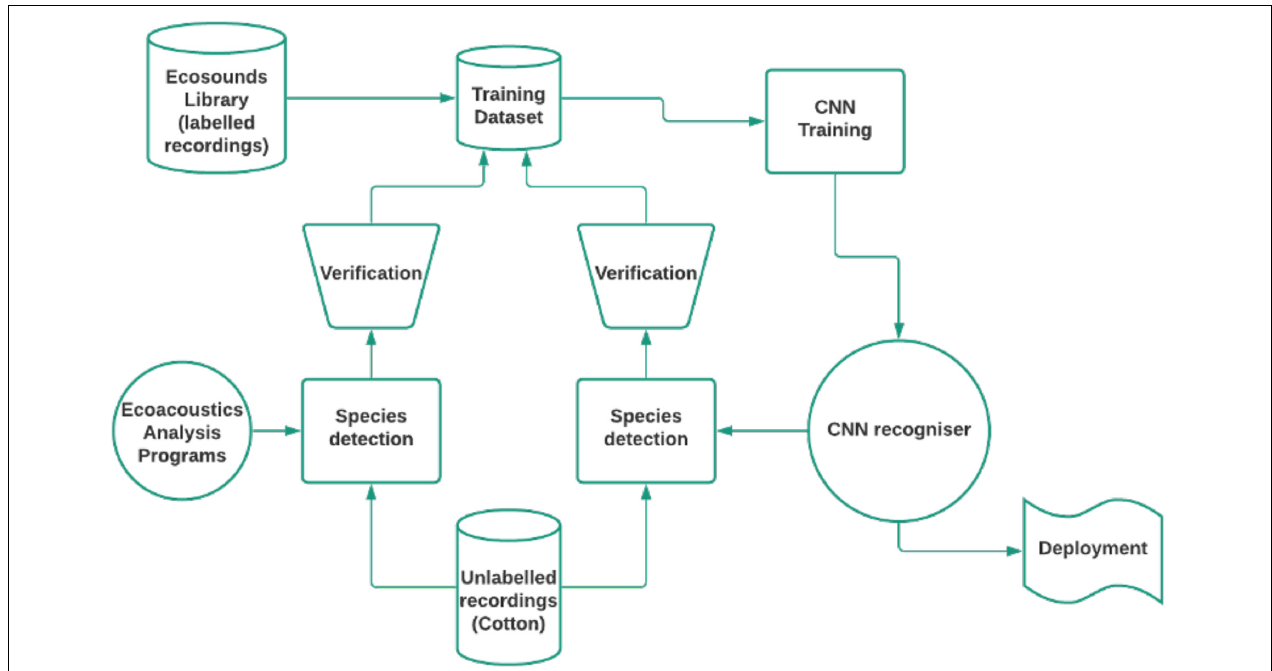
FIGURE 3 | Iterative workflow for verifying classification results.